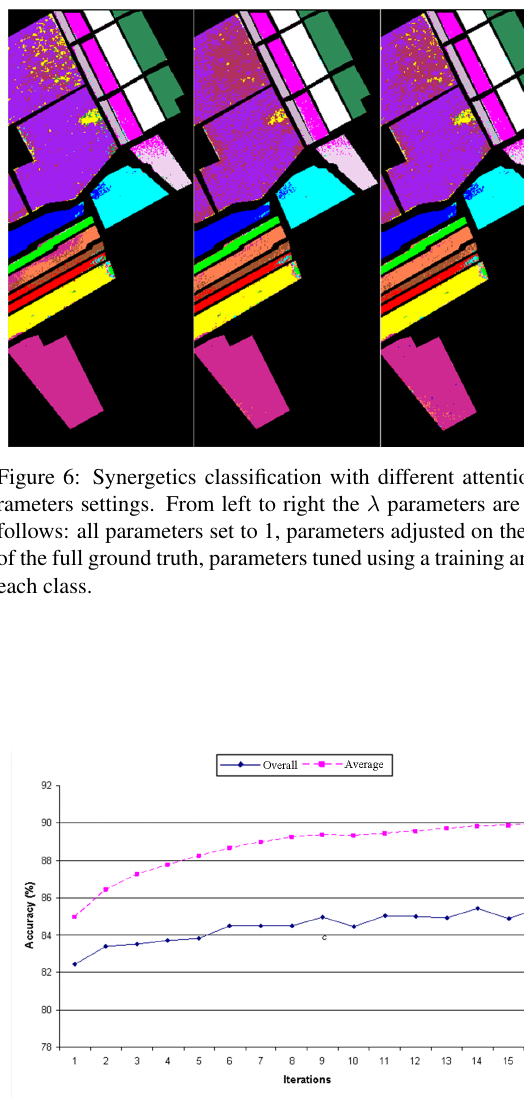
Figure 7: Increase in overall and average accuracy after automatic tuning of the λ parameters.